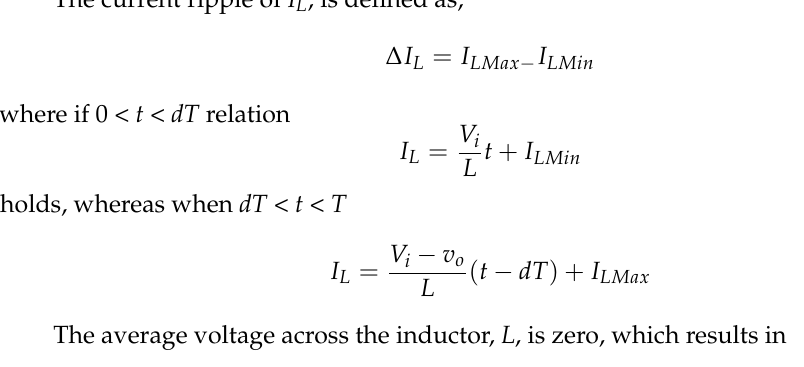
Figure A2. Voltage and current during continuous conduction mode .